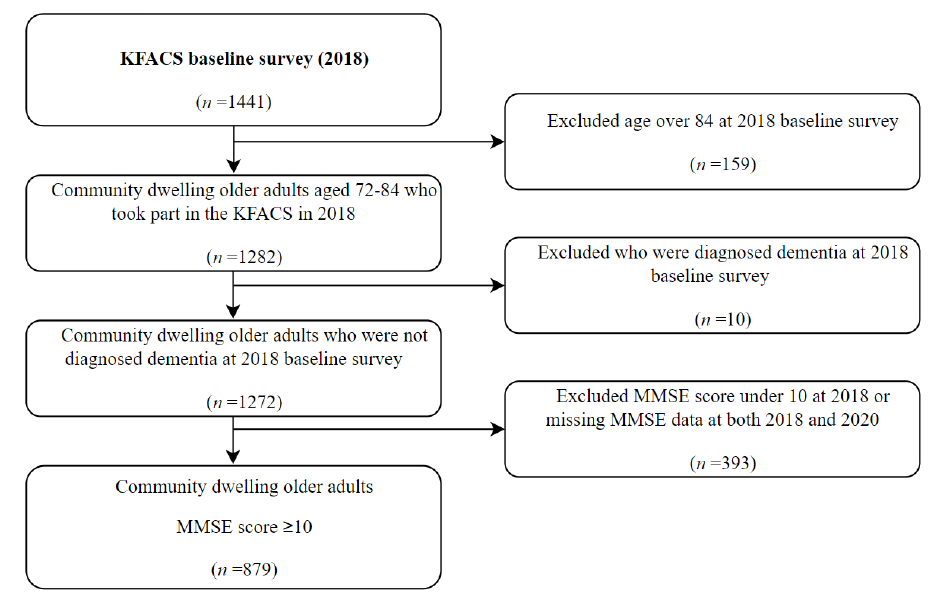
Figure 3. Flowchart of the study population of KFACS 2018 group.